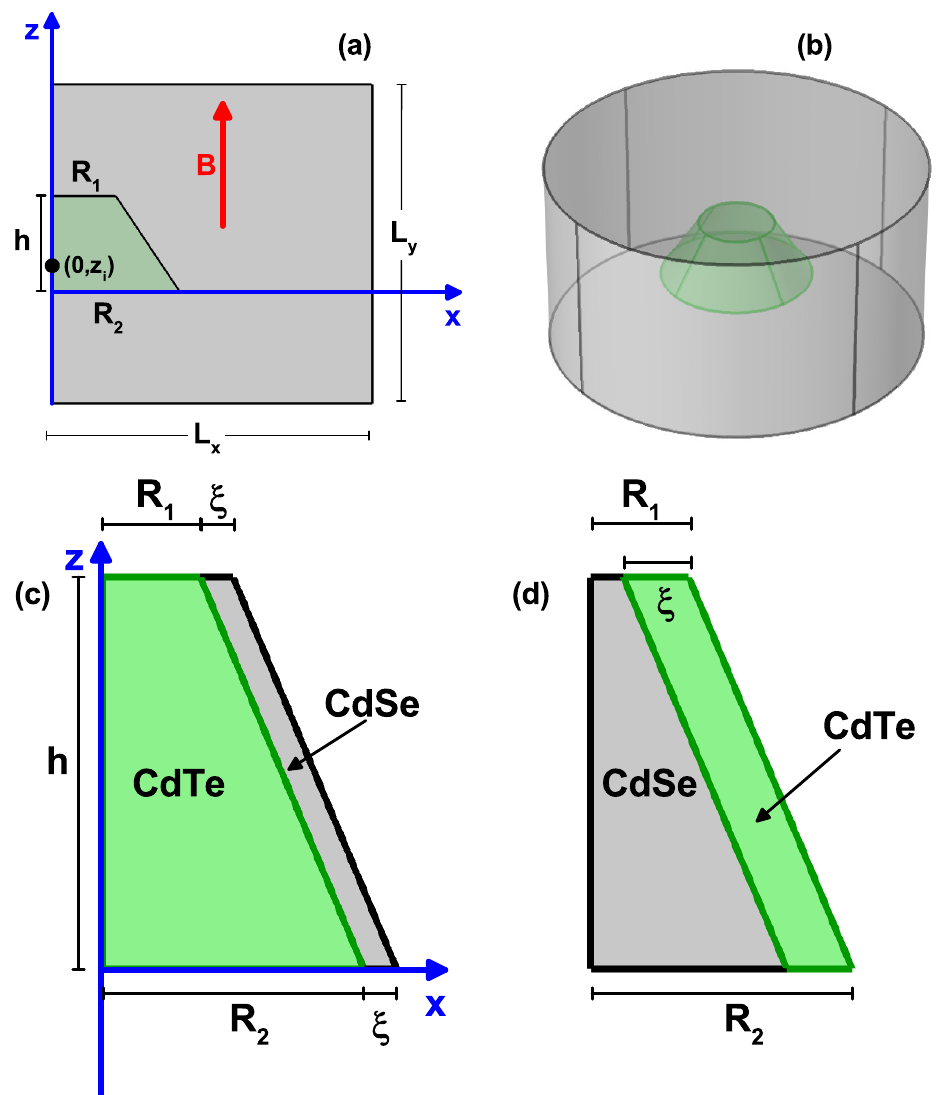
Figure 1. Schematic view of the truncated conical-shaped GaAs-Al 0.3 Ga 0.7 As quantum dot, (cone region GaAs, outside the cone AlGaAs). In ( a ) is depicted the ϕ = 0 projection, where the dot dimen- sions ( R 1 , R 2 , and h ), the shallow donor impurity position ( 0, z i ) , the reference frame, the vertically applied magnetic field, and the dimensions of the large-size square where the open and Dirichlet boundary conditions are applied ( L x = L y = 50 nm), are indicated. The position of the cone half- height coincides with the half-height of the large square, and the reference frame coincides with the base of the cone. In ( b ) is shown the structure obtained by rotating around the z -axis the structure represented in ( a ). Schematic view of the truncated conical CdTe–CdSe ( c ) and CdSe–CdTe ( d ) core–shell quantum dots. The ξ -parameter corresponds to the shell width of CdSe ( c ) and CdTe ( d ). R 1 and R 2 are the base radii, and h is the QD height. In ( c , d ), the impurity and magnetic field effects have been